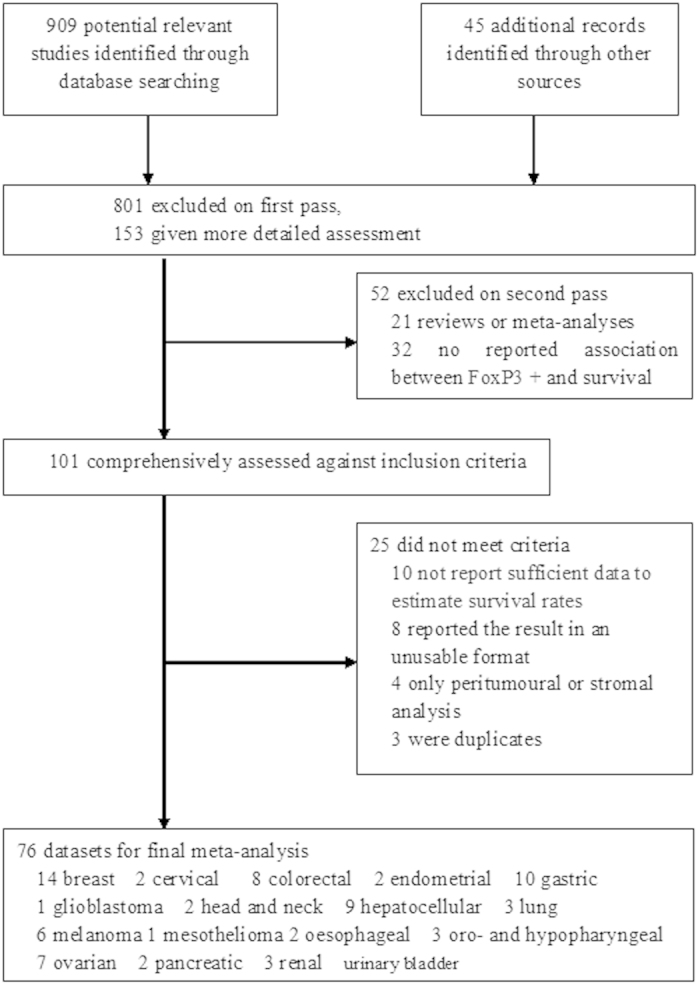
Flow diagram of search strategy and study selection.